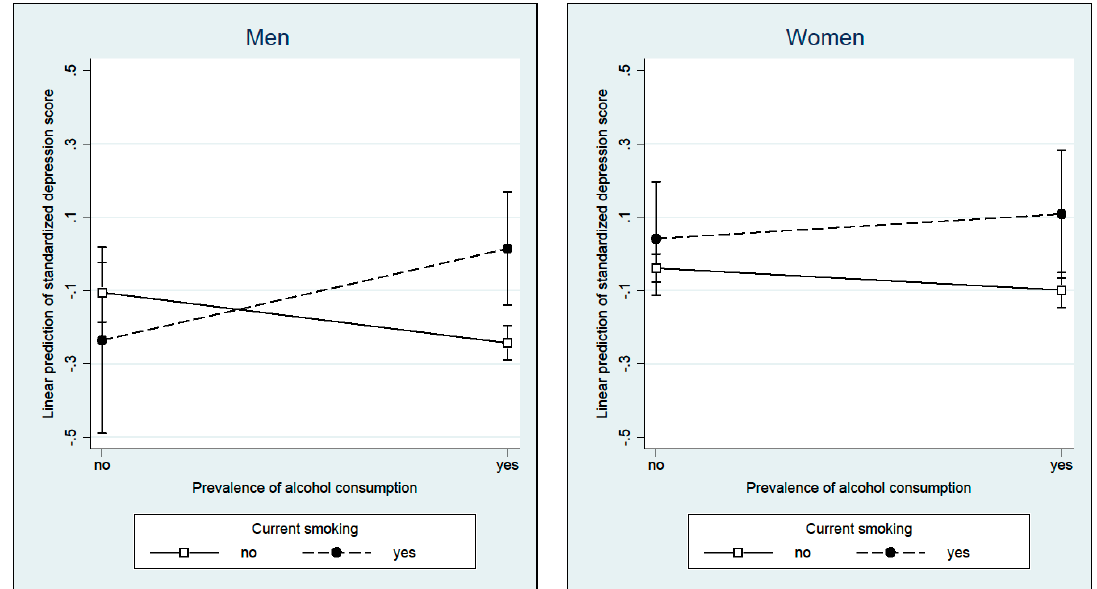
Figure 2. Gender differences for substance use.